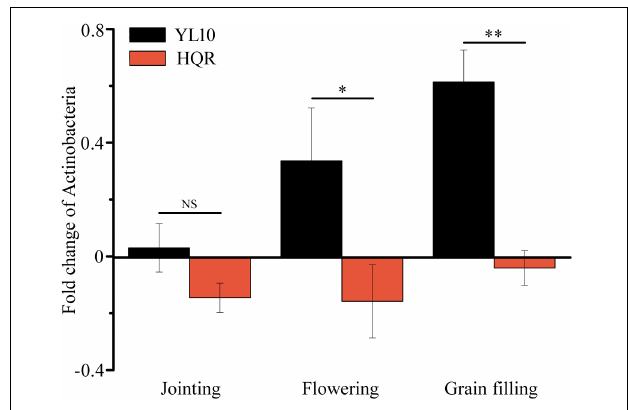
FIGURE 3 | Effect of drought stress on the relative abundance of Actinobacteria in the rhizosphere of broomcorn millet. The fold change of Actinobacteria was calculated using the following equation: (relative abundance under drought/relative abundance under control) –1. Error bars are standard error over three independent replicates ( n = 3). NS indicates no significant difference between HQR and YL10; ∗ p < 0.05; ∗∗ p < 0.01.